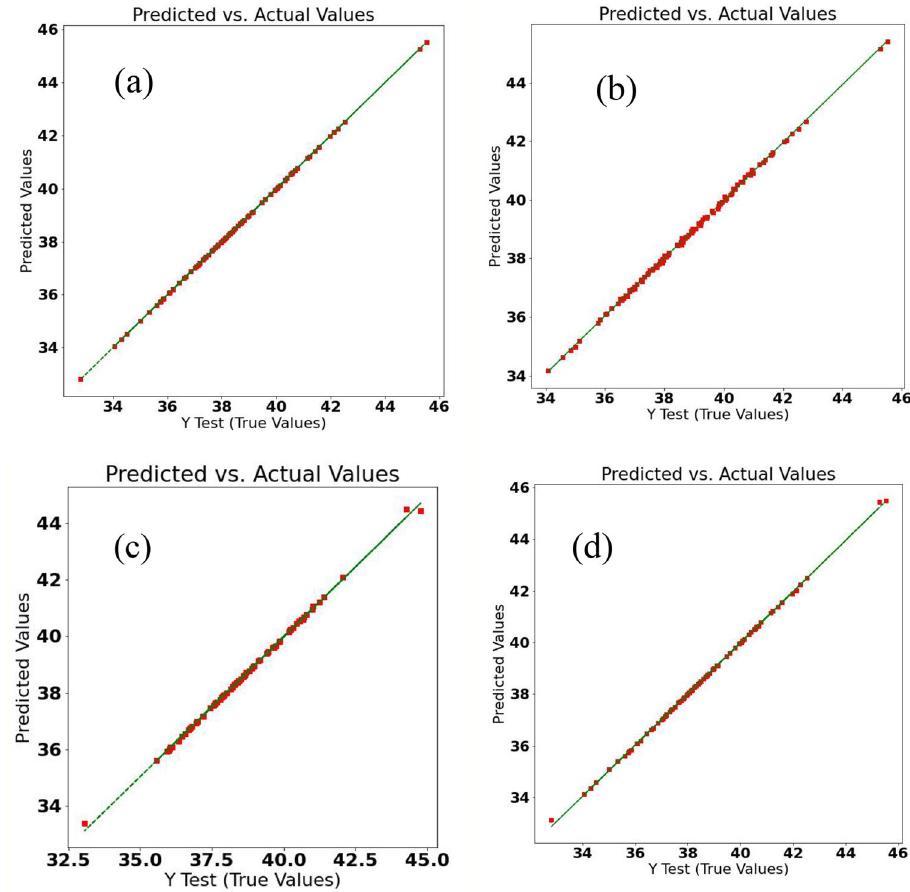
Figure 5. ( a ) Linear ( b ) Support vector, ( c ) Random forest, and ( d ) gradient boosting regressions of the oil percentage of the Lallemantia iberica